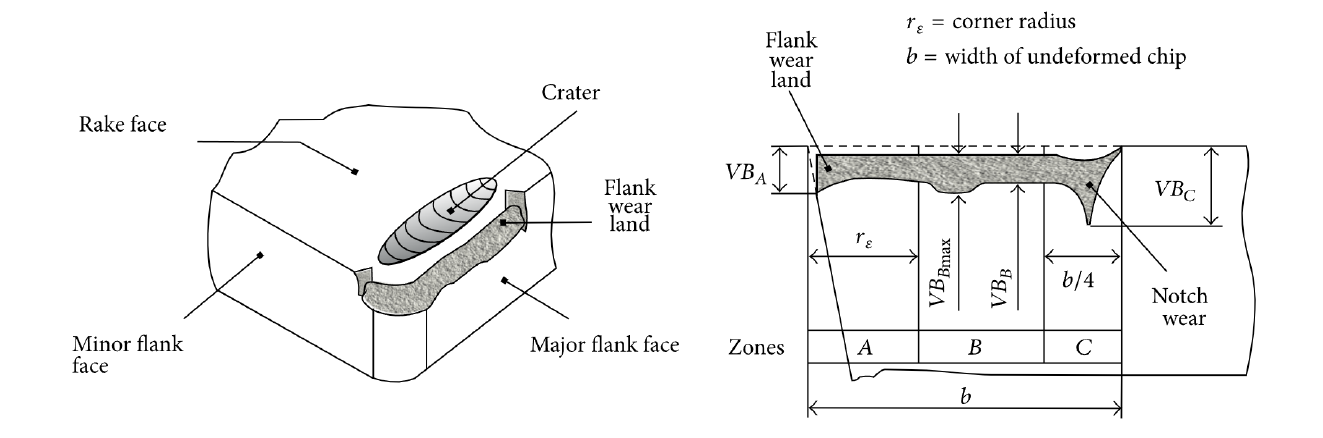
Figure 2. Tool wear standardized measurement [19]. Image from Jozi´c et al. [20] under Creative Commons Attribution License